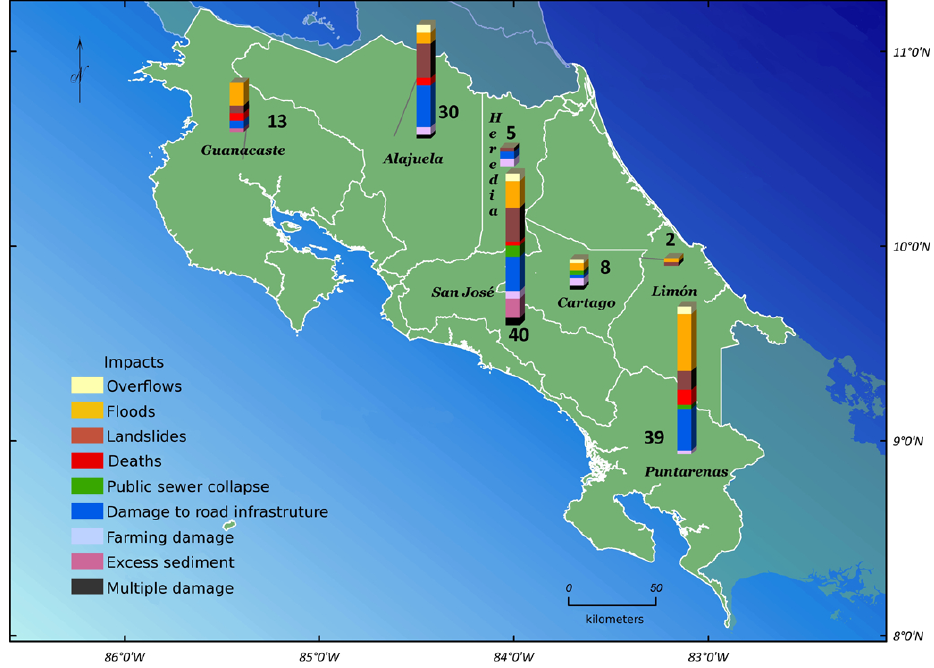
Fig. 13. Spatial distribution, by province, of the impacts and disasters due or related to hydro-meteorological causes during ASO 2010 season. Numbers are the sum of the categories listed. They were compiled from national newspapers of Costa Rica.